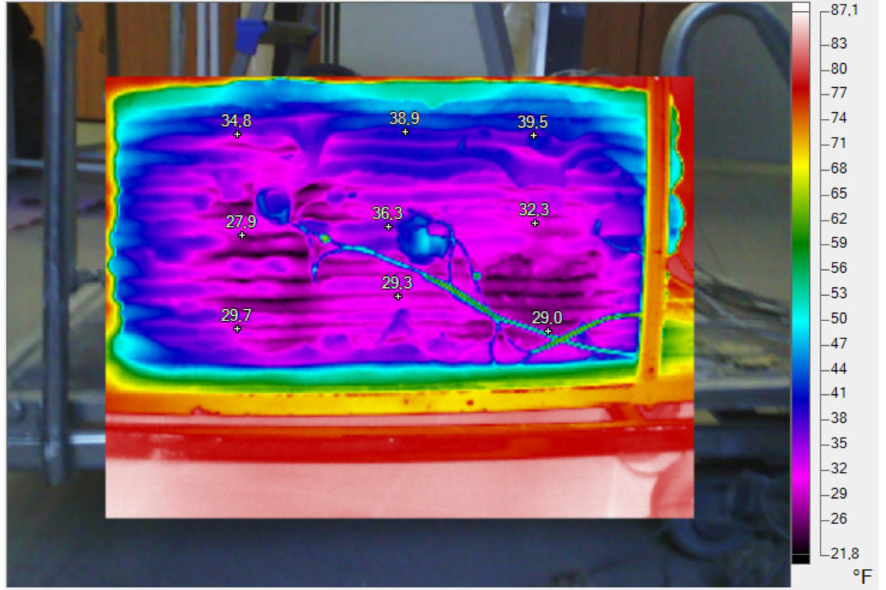
Figure 19. Thermal imaging of 3D-printed wall. The frequency of filming is 20 min. Table 10 presents the